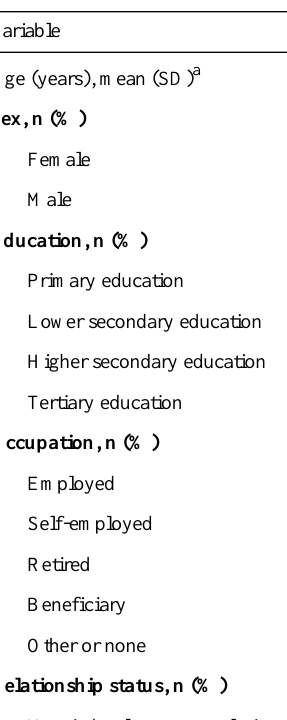
Table 2. Participant characteristics